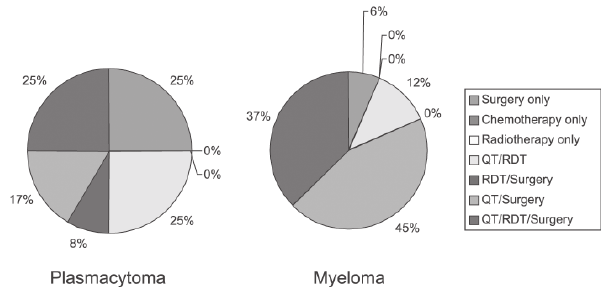
Figure 8 - Type of treatment received by patients with plasmacytoma and by patients with plasmacytoma that progressed to multiple myeloma (absolute and relative frequency distribution)